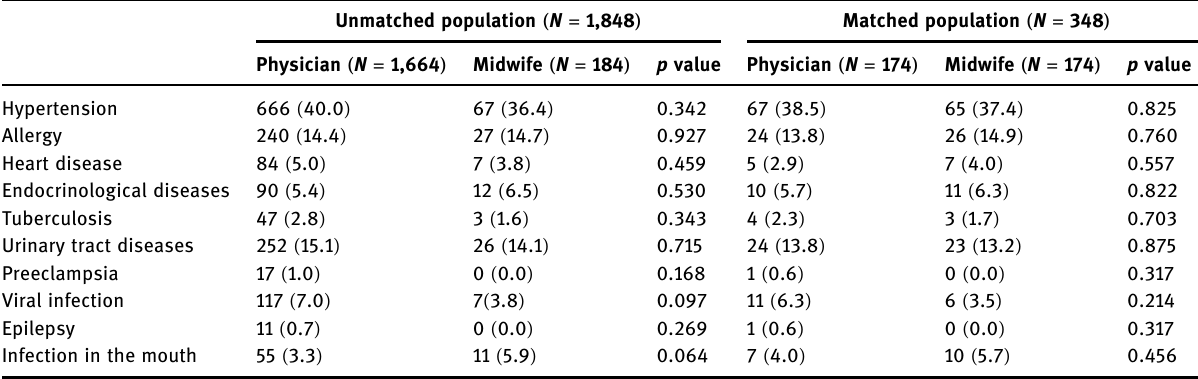
Table 2: Systemic disorders of study participants in the unmatched and matched study